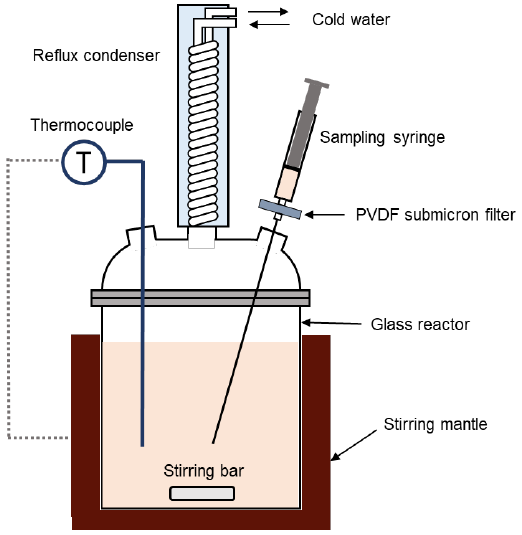
Figure 2. A schematic diagram of the experimental apparatus for precipitation reaction of ferrous oxalate in oxalic acid aqueous solution. Table 1. Experimental conditions for the precipitation reaction of ferrous oxalate in oxalic acid aque- ous solution.